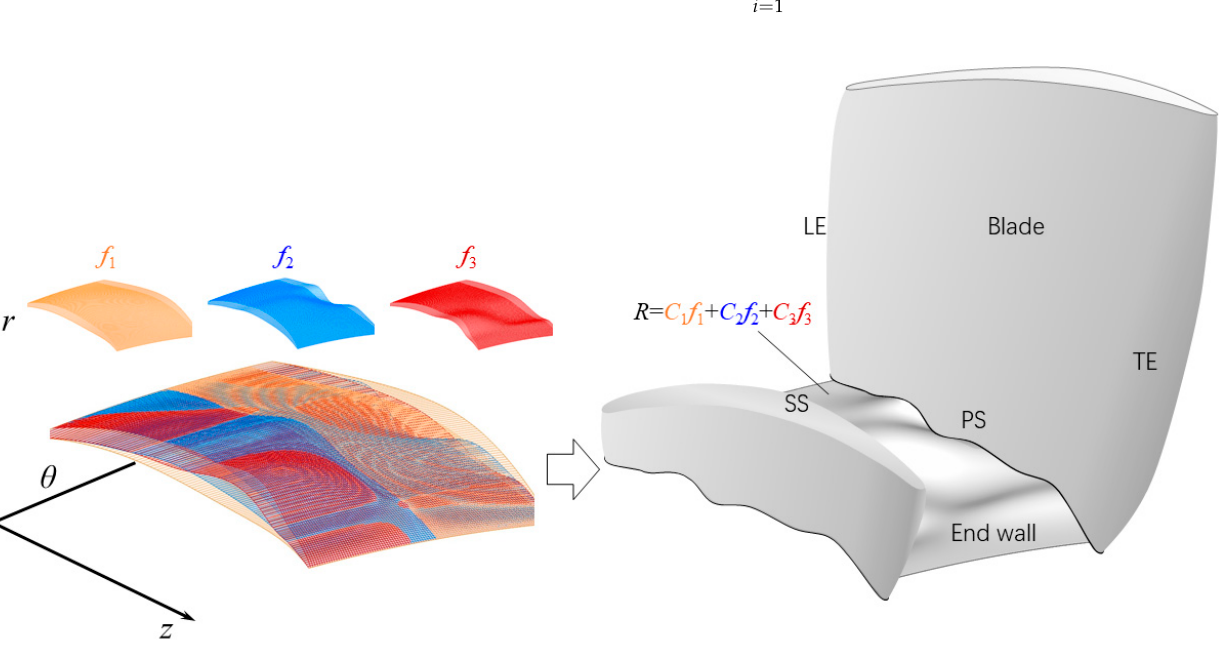
Figure 1. Basic idea of the new end wall contouring method.